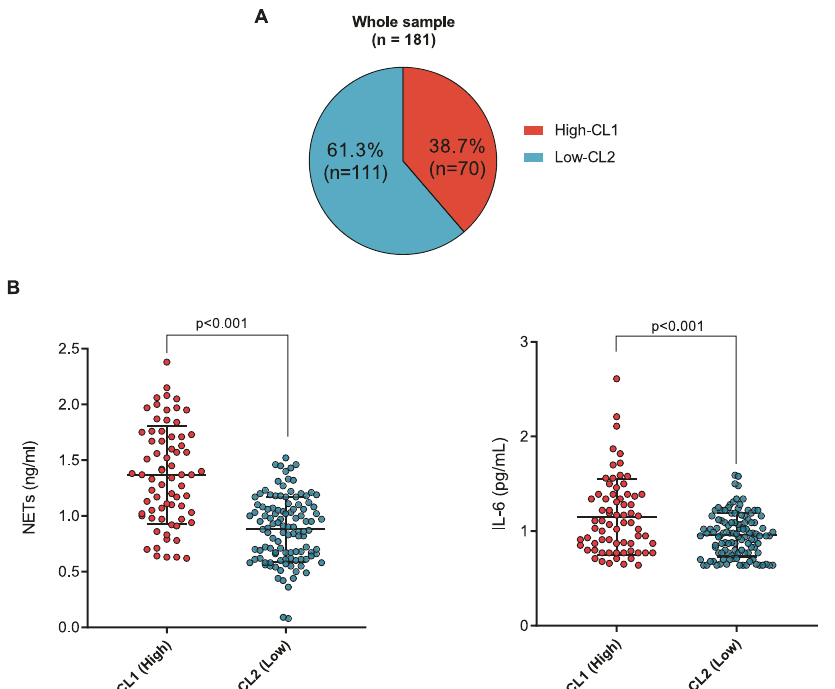
Fig. 3 Sample strati fi cation in the whole sample ( n = 181) using unsupervised two-step cluster analysis and subgroup differences in NETs and IL-6 plasma levels. A Two main clusters were identi fi ed when integrating values of childhood maltreatment scores, NETs, and IL-6 levels. Cluster 1 (high-CL1) represents participants with higher scores of childhood maltreatment and levels of NETs and IL-6, whereas cluster 2 (low- CL2) represents the opposite. B Participants allocated to high-CL1 had signi fi cantly higher levels of NETs and IL-6 than the low-CL2 (one-way analysis of covariance with Bonferroni post-hoc adjusted for tobacco smoking and other recreational drugs). NETs and IL-6 (mean, SD) are represented as natural-log transformed